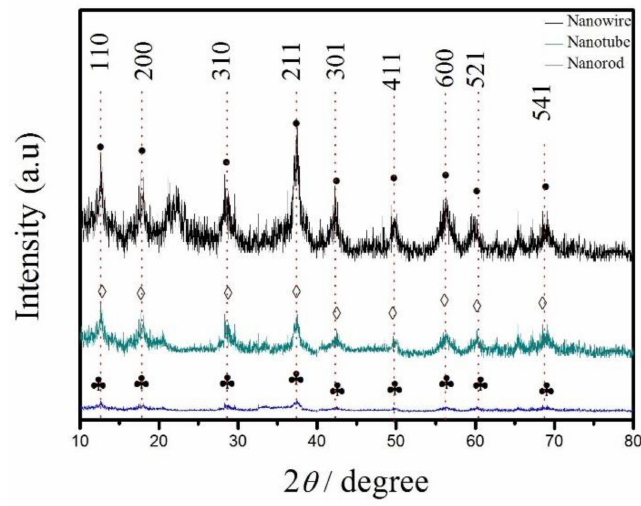
Figure 2. X-ray diffraction (XRD) patterns of MnO 2 NWs, MnO 2 NRs, and MnO 2